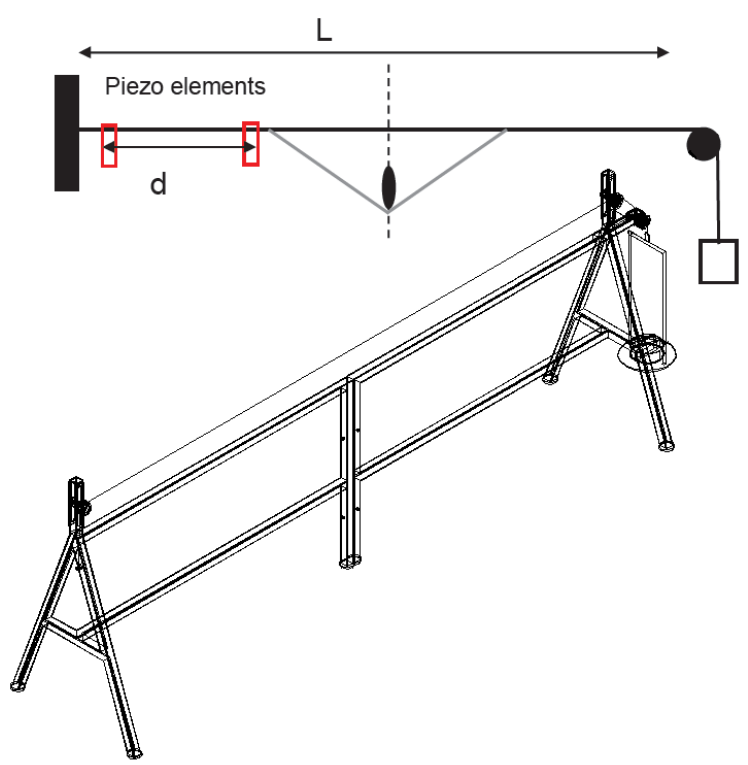
Figure 4. Yarn shooting apparatus.